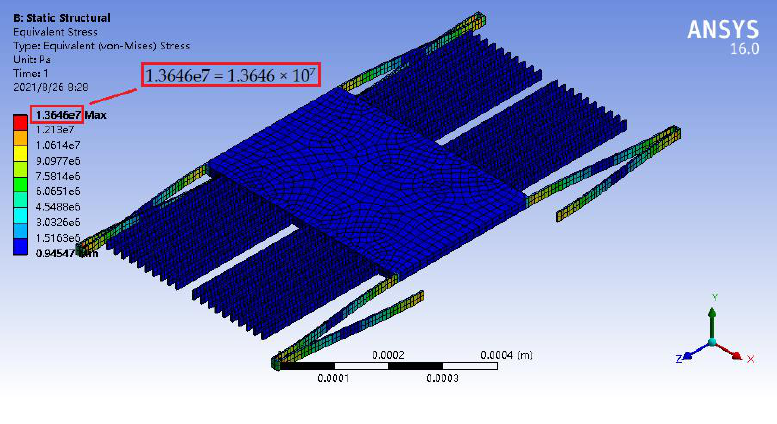
Figure 17. Stress nephogram of the micro-accelerometer under the acceleration of 100 g at 1000 °C.